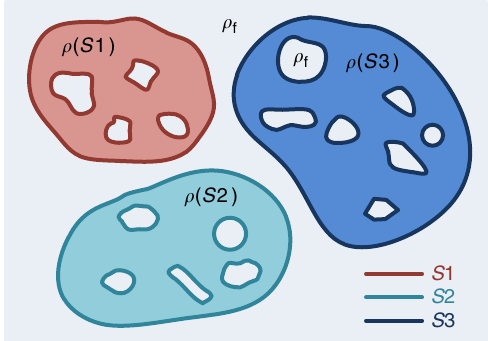
Fig. 1 Schematic illustration of a heterogeneous porous material. There are both internal and external interfaces, S , between the matrices and the pores accessible to the probing fl uid in the heterogeneous porous material. The material has surface heterogeneity which represents the coexistence of different chemical and structural properties on the surfaces. Different colors represent matrices with different scattering length densities (SLDs), ρ ( S ), and the lines depict the interface, S . ρ f is the SLD of probing It should be noted that integrals in Eqs. (1) – (3) are evaluated over , ρ 2 , and Δ 2 are the interface S , not the material volume V ; ρ H A M surface averaged, not volume averaged parameters. Δ H is called the normalized surface heterogeneity. It char-